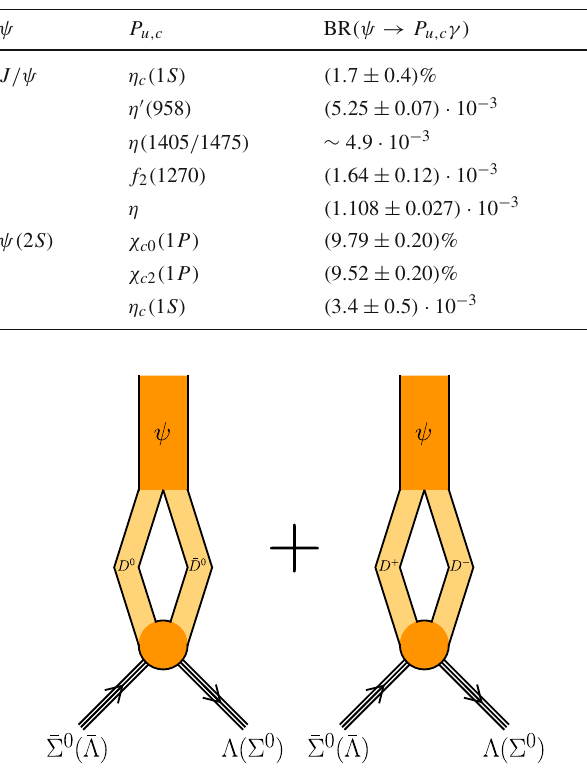
Table 4 All available BRs larger than 10 − 3 for the decays ψ → P u , c γ , with ψ = J /ψ and ψ( 2 S ) [5]. The BR of the decay J /ψ → η( 1405 / 1475 )γ is the sum of those of 5 sub-channels